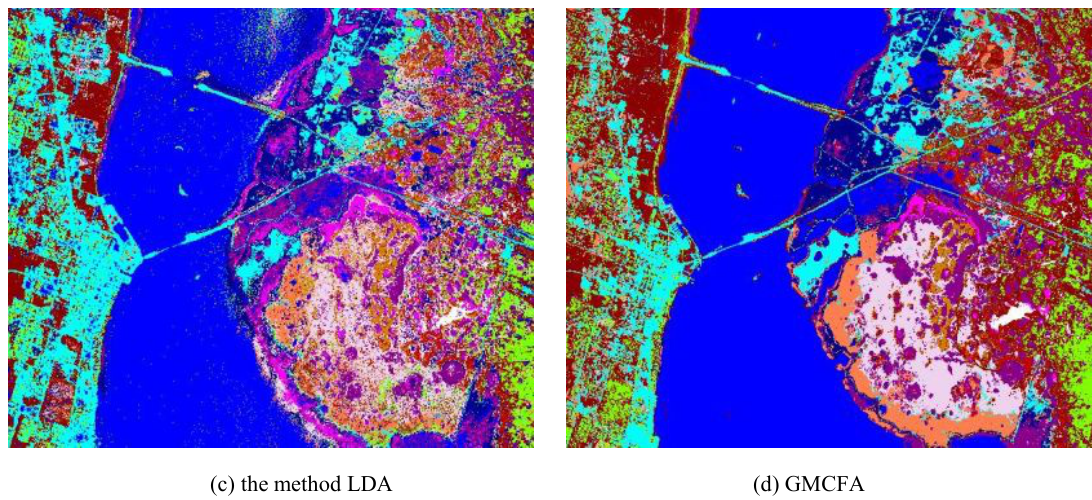
Fig.5 The comparison of classification results map using maximum likelihood algorithm under different dimension reduction algorithm of AVIRIS data